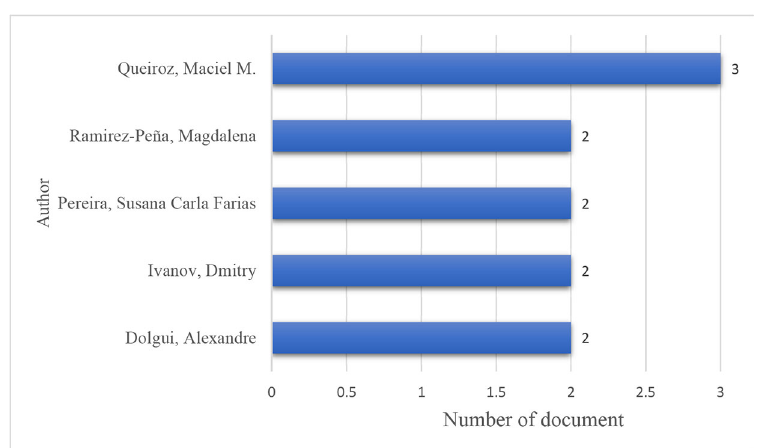
Figure 9. High contributing